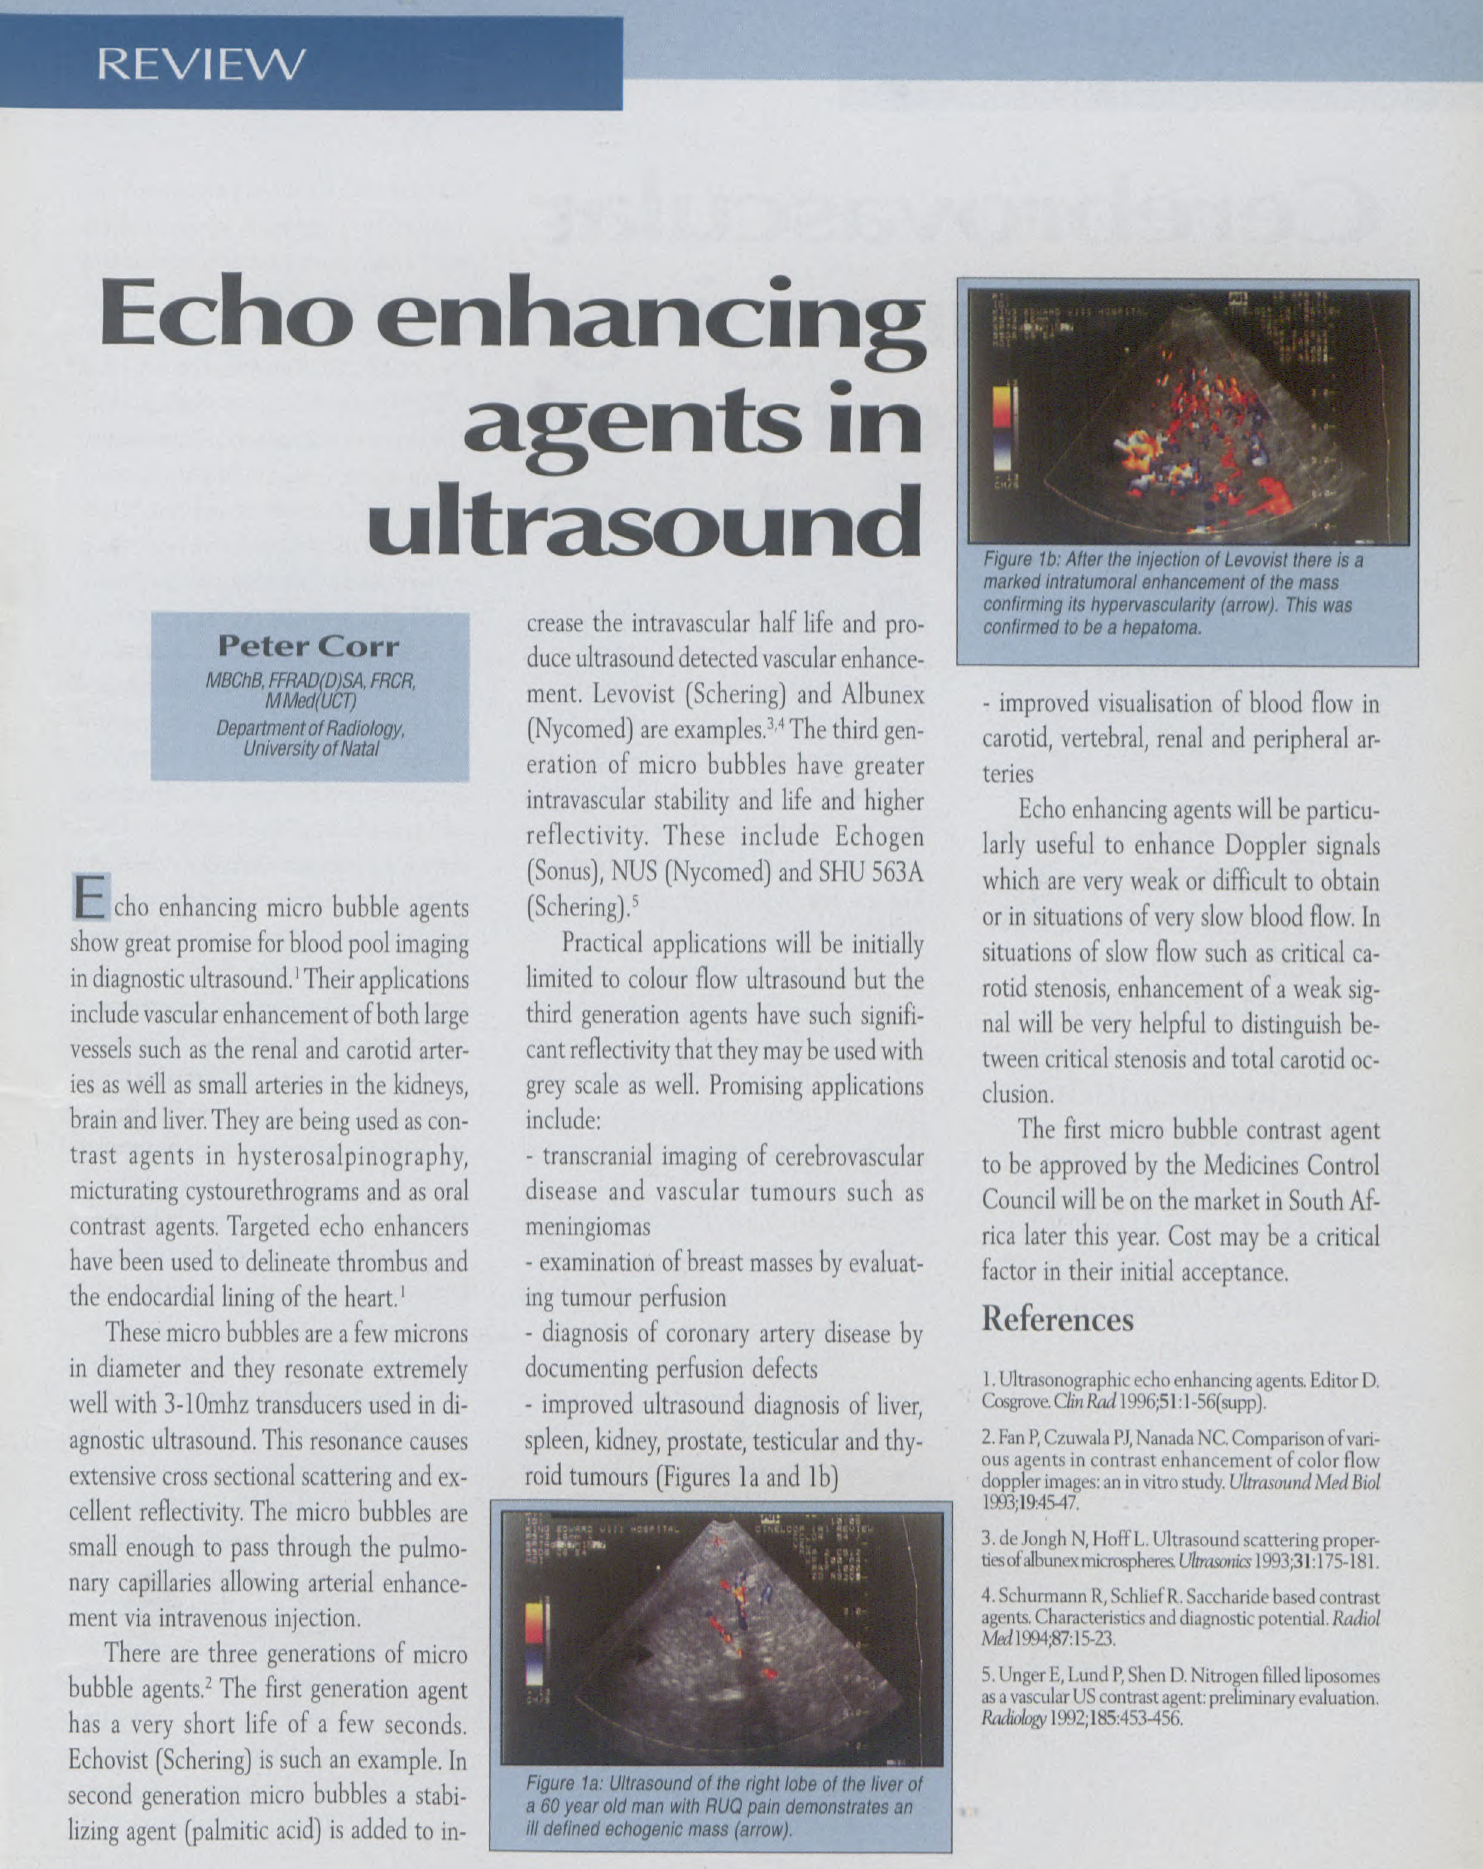
Figure 1b: After the injection of Levovist there is a marked intratumora/ enhancement of the mass confirming its hypervascu/arity (arrow). This was confirmed to be a